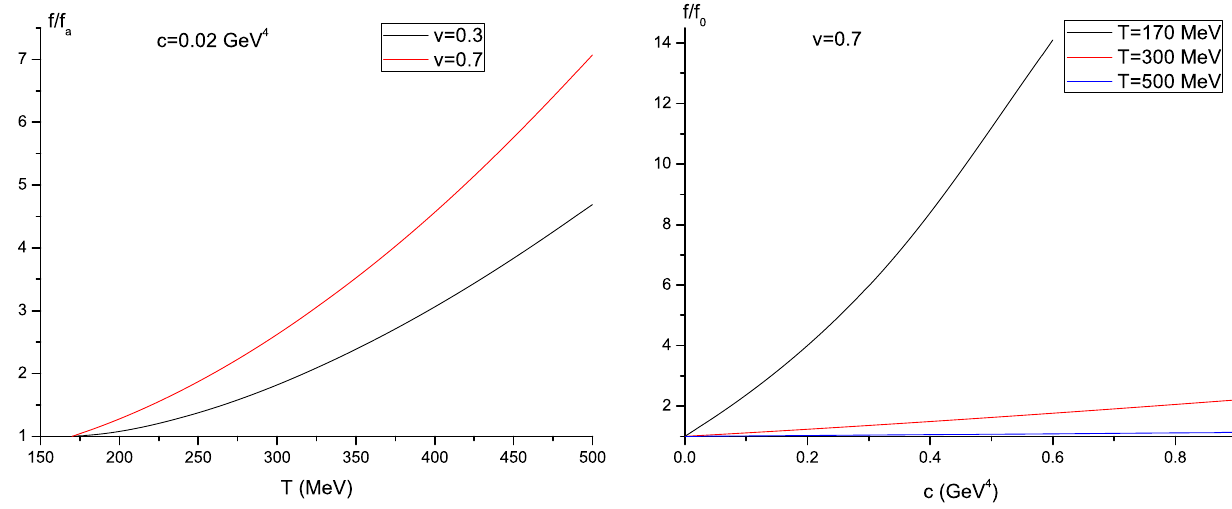
Fig. 3 Left: f / f a versus a . Right: f / f 0 versus c . Here we take the speed of light as